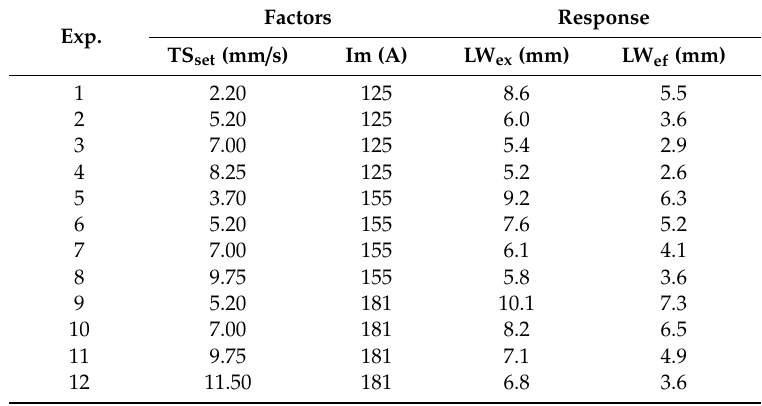
Figure 17. Comparison of first approximate versus second approximate versus the actual operational maps.